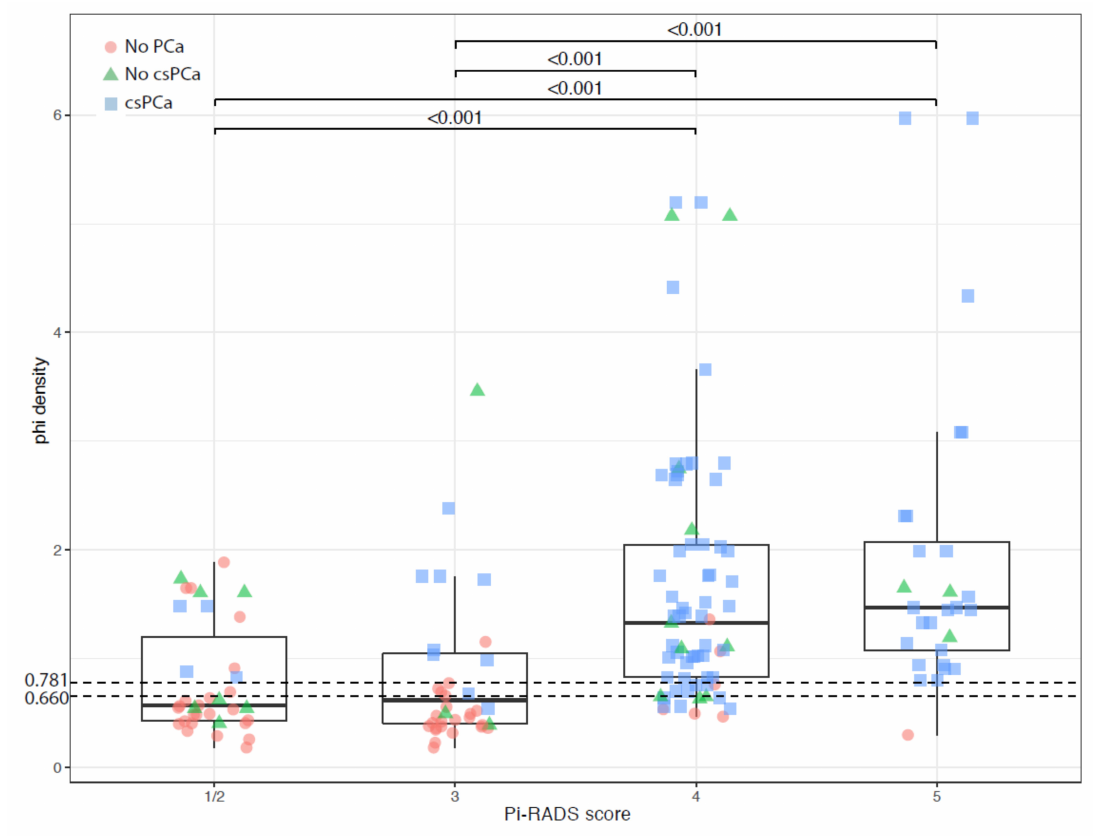
Figure 4. Boxplot showing distribution of PHI density according to PI-RADS v2 score. Dashed lines indicate cut-off values. Data are shown as median (bold horizontal line in the box) and Q1 and Q3 (borders of the box). Whiskers represent the lowest and the highest values that are not outliers (i.e., data points below Q1 − 1.5 × IQR or above Q3 + 1.5 × IQR). Outliers are those outside the whiskers. Q1 = 25th percentile; Q3 = 75th percentile; IQR (interquartile range) = Q3 − Q1; csPCa, clinically significant prostate cancer; PI-RADS, Prostate Imaging Reporting and Data System; PHI, prostate health